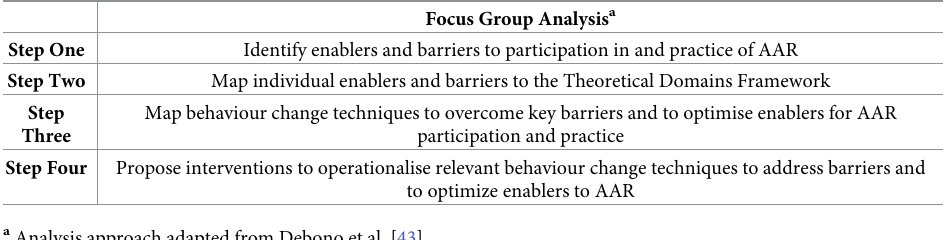
Table 2. Approach to focus group analysis using the theoretical domains